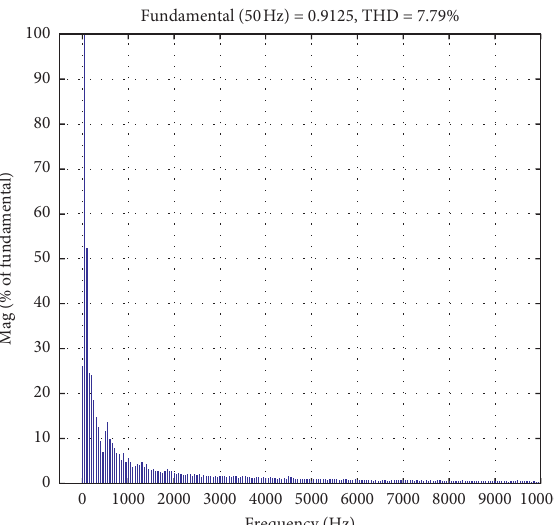
Figure 11: Spectrum analysis of stator current using the Luenberger and the reduced-order